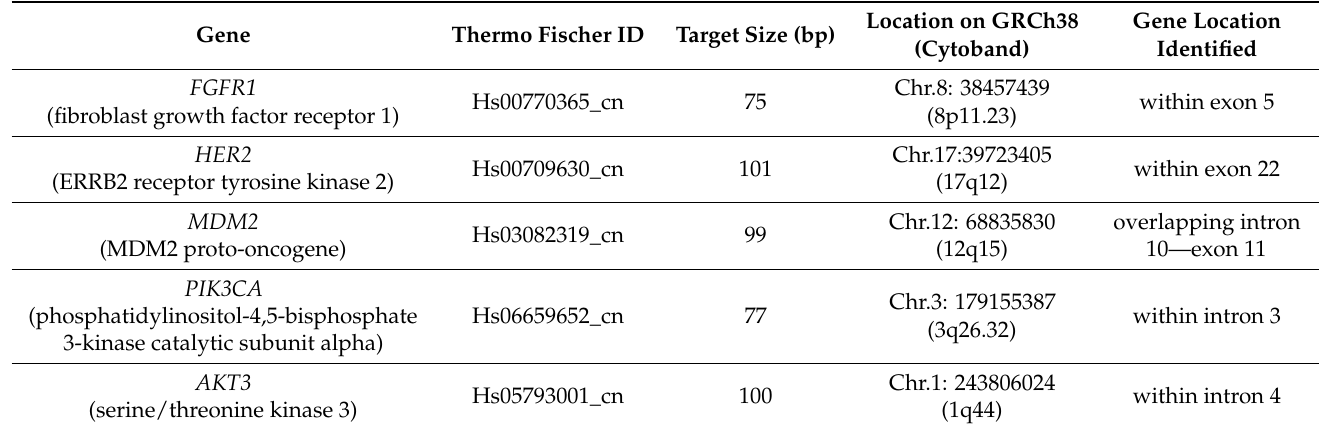
Table 1. Details of the assays and genes used in the detection of